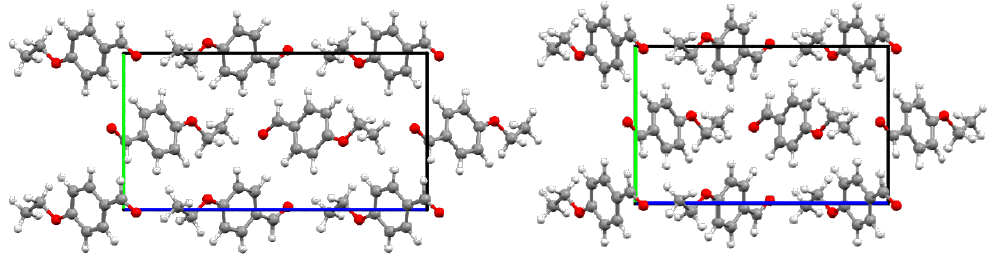
Figure 4. Optimized crystal structure of 4EtOB with fixed ( left ) and relaxed ( right ) cell, viewed along the “a” axis. Table 5. Selected geometrical parameters for